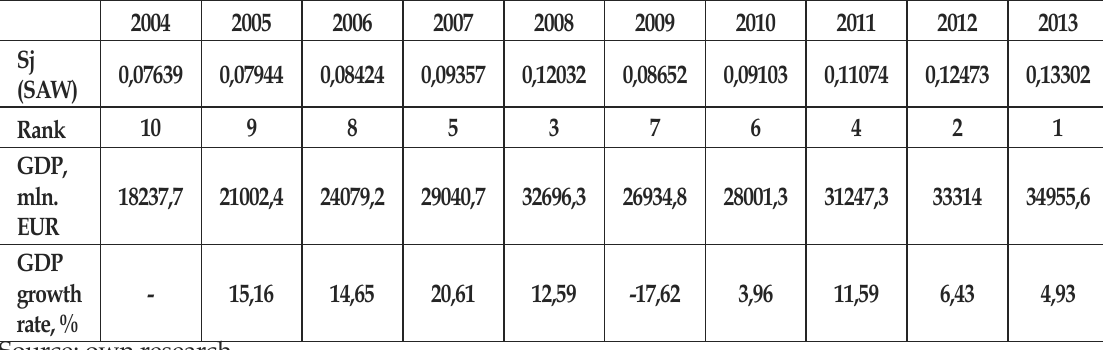
Tab.1. The results of SAW method